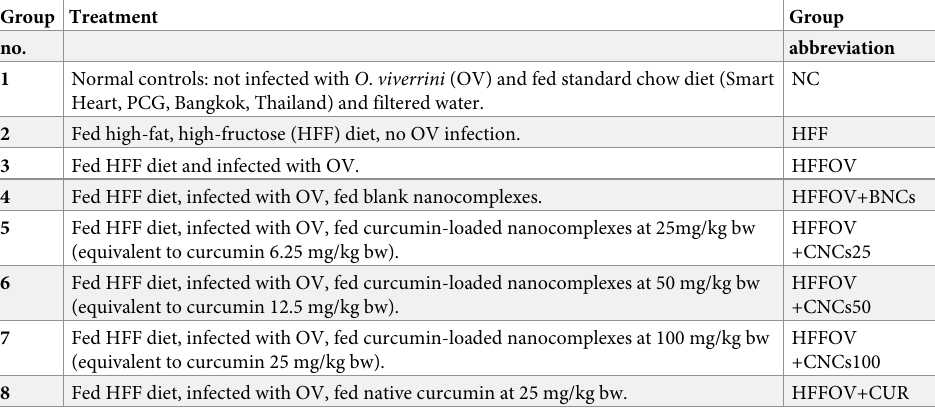
Table 1. Experimental design and animal